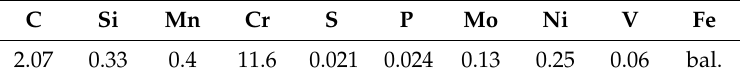
Table 1. Chemical composition of X210Cr12 tool steel [wt %].